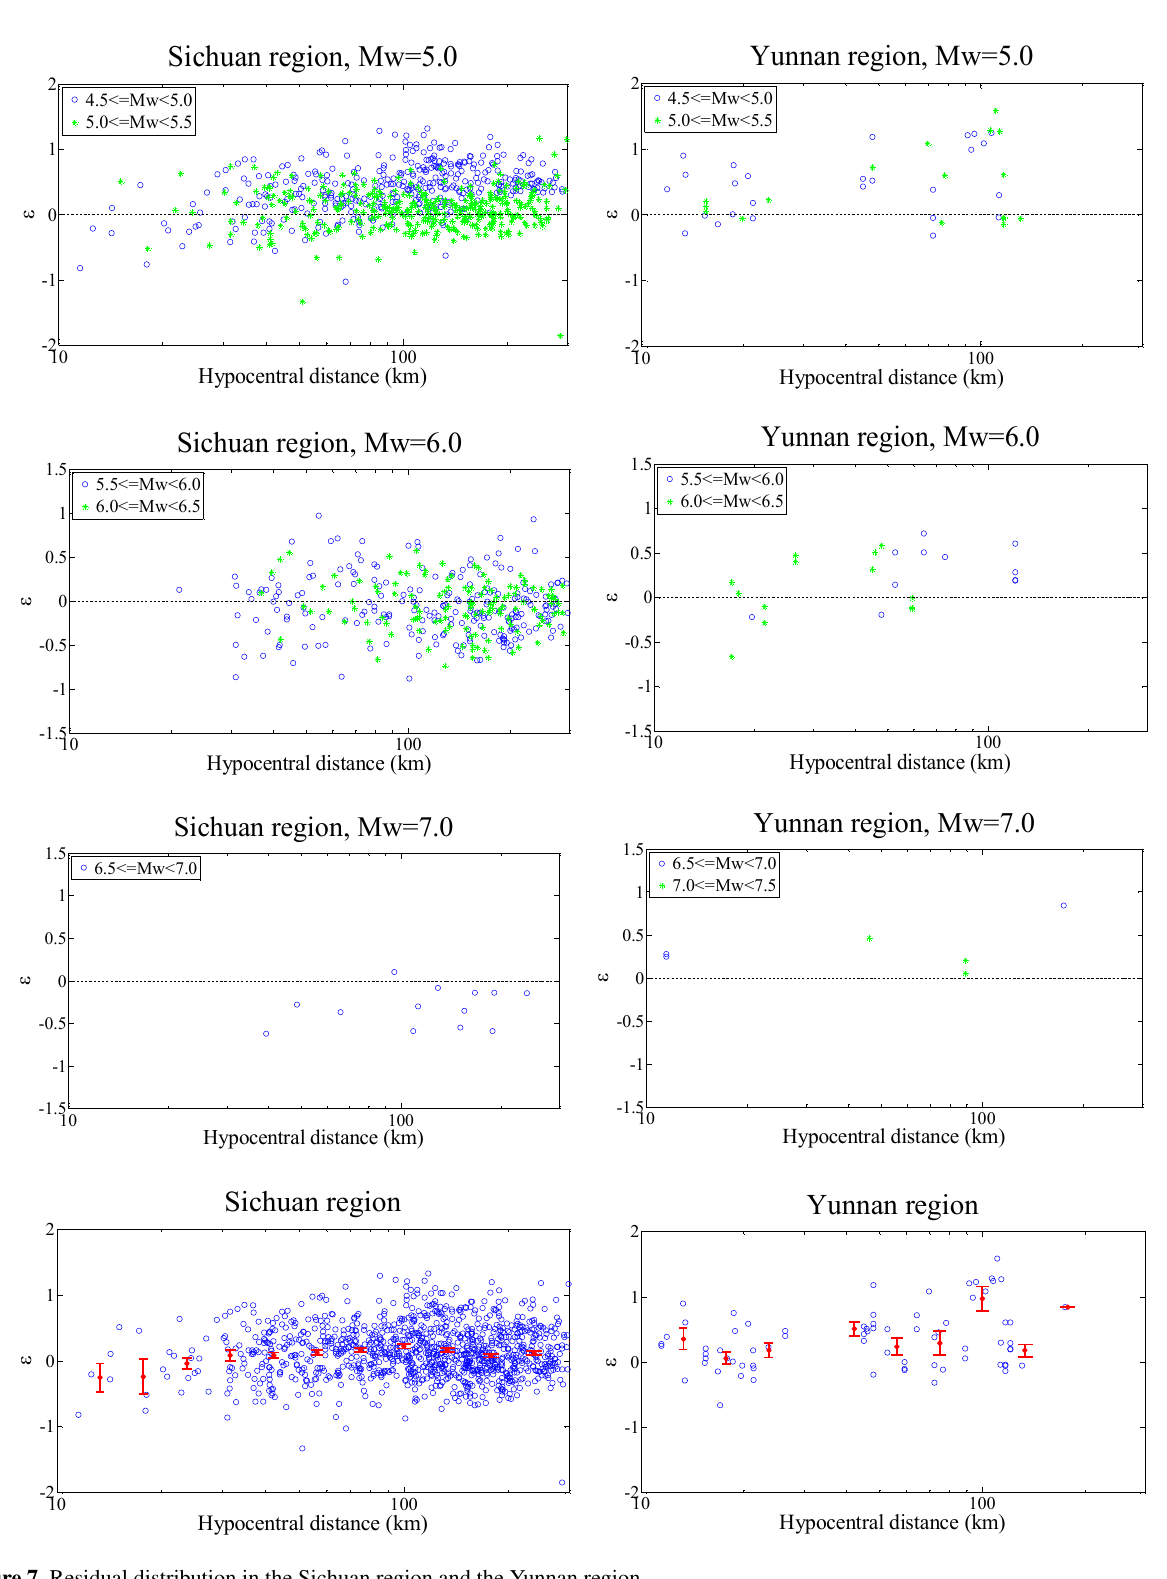
Figure 7. Residual distribution in the Sichuan region and the Yunnan